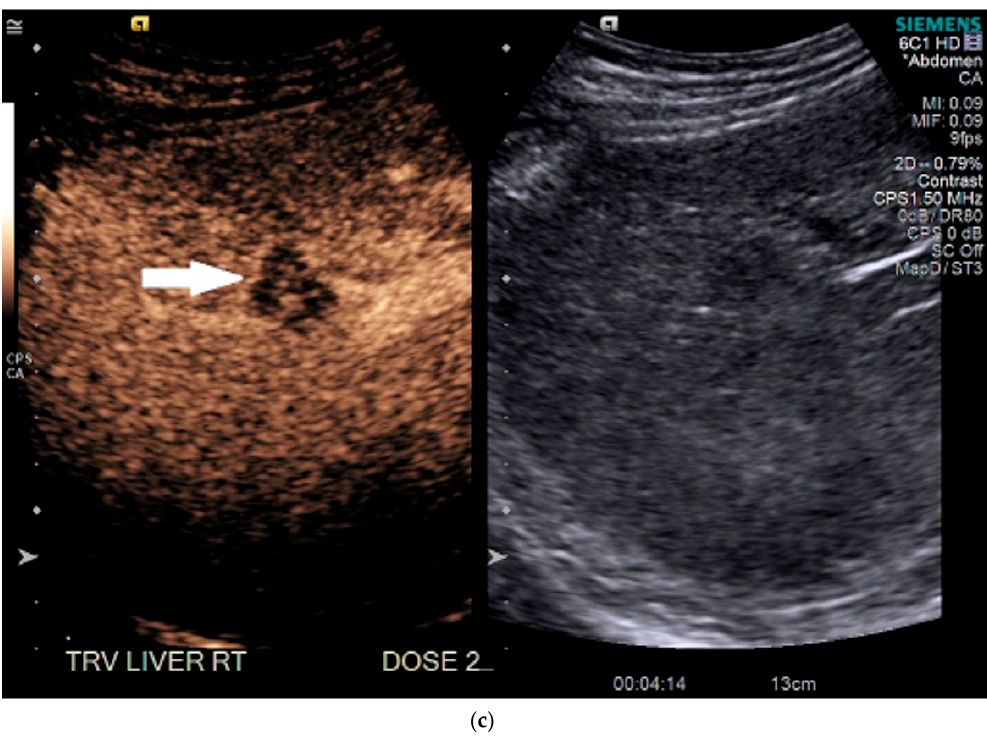
Figure 1. Patient 1 ultrasound images, with liver lesion denoted by white arrow: ( a ) grayscale images showing the hypoechoic lesion. Post contrast administration ultrasound in arterial phase with matched low-mechanical-index B-mode grayscale on the right and subtraction-type post contrast images on the left ( b ) and delayed phase ( c ) of the lesion, which shows marked washout. Liver Reporting and Data System (LI-RADS M).